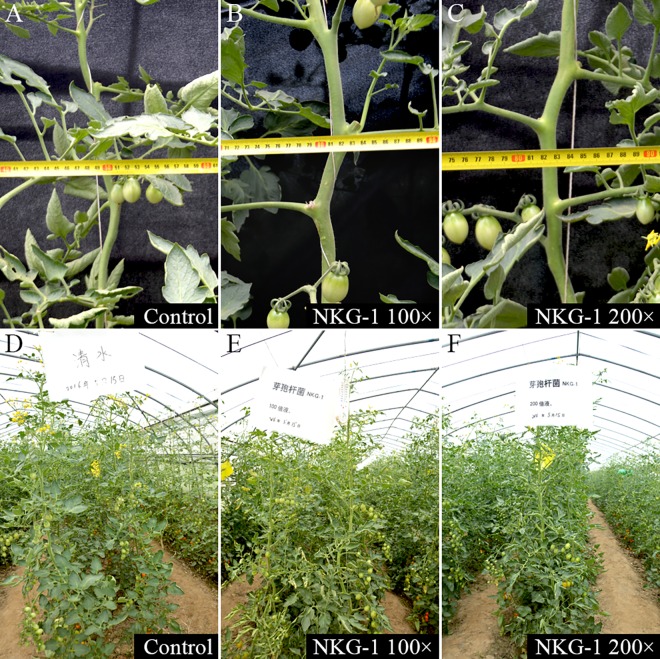
Promotion of tomato plant growth in the field by B. methylotrophicus strain NKG-1.(A) and (D) tomato seeding plants without any treatment over 3 months (control); (B) and (E) tomato seeding plants after root irrigation and spraying with 100× diluted broth over 3 months; and (C) and (F) tomato seeding plants after root irrigation and spraying with 200× diluted broth over 3 months.